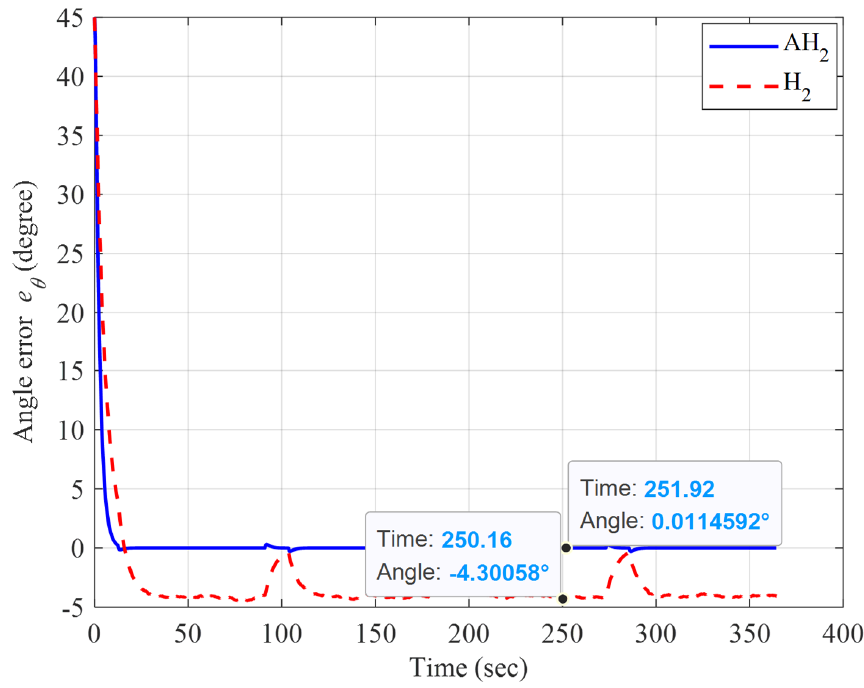
Figure 13. The square trajectory tracking error result of the adaptive H 2 closed-form and H 2 closed- form control approaches for angle from x p = − 7 m, y p = − 7 m.